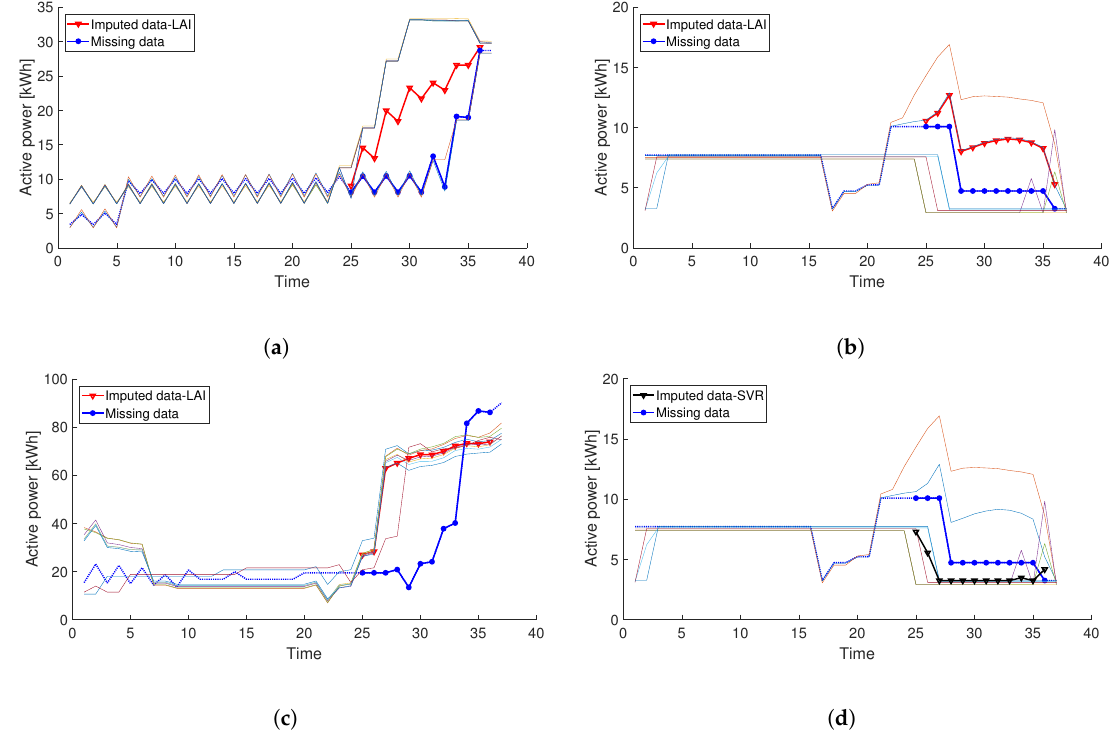
Figure 15. Example of difference between imputed data and missing data. ( a ) Unexpected variation in past situations for imputation, normal case; ( b ) unexpected variation in past situations for imputation, extreme case; ( c ) unexpected variation in current missing situation; ( d ) an example of imputation using